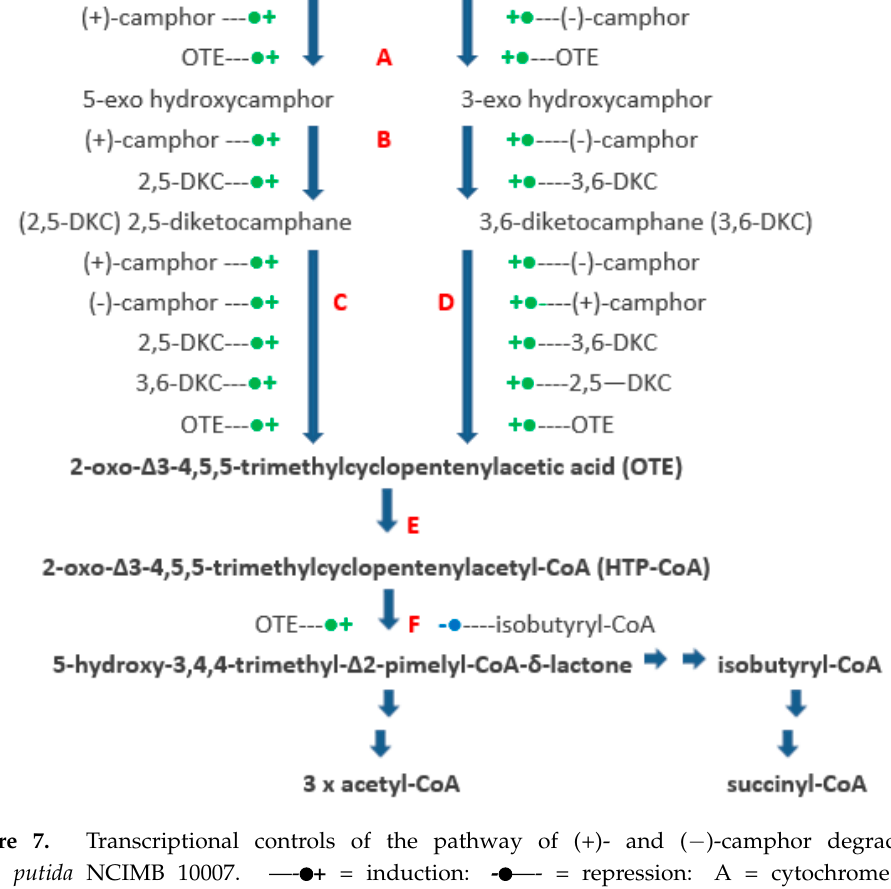
Figure 7. Transcriptional controls of the pathway of (+)- and ( − )-camphor degradation in P. putida Transcriptional controls of the pathway of (+)- and ( − )-camphor degradation NCIMB 10007. ---- ● + = induction: - ● ---- = repression: A = cytochrome P450 monooxygenase ( camCAB ): B = in P. putida NCIMB